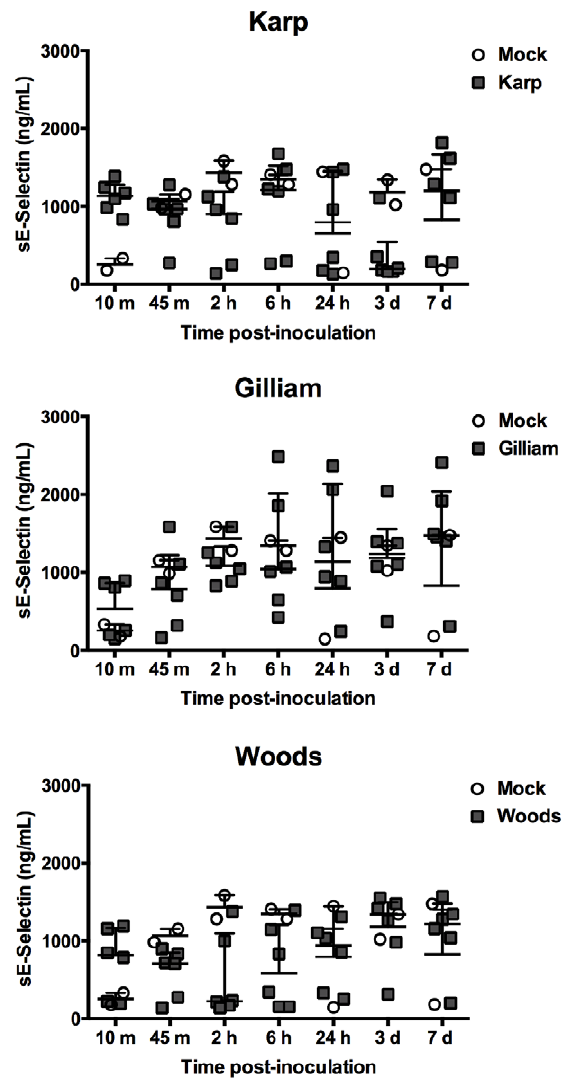
Figure 2. Serum levels of circulating soluble E-selectin. Dot plots demonstrate sE-selectin levels in inoculated mouse sera. (Mock inoculation; n=2 per time point, O. tsutsugamushi inoculation; n=6 per time point). Bars indicate median and error bars represent interquartile range.